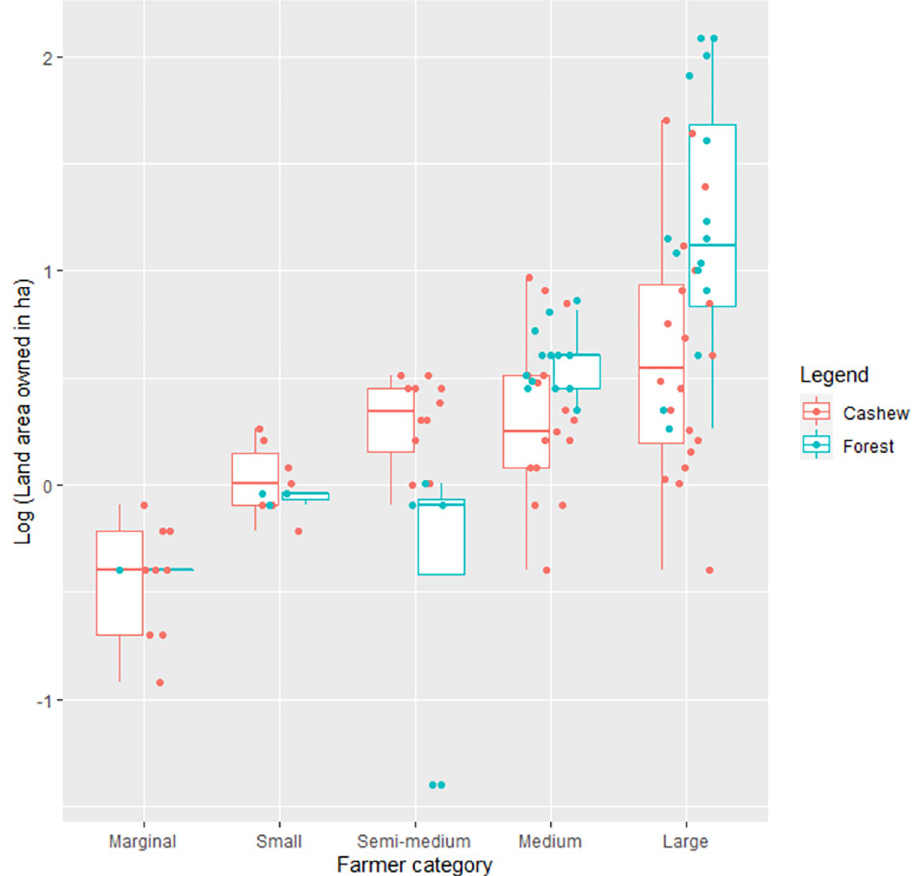
Fig 4. Boxplots of land area under cashew cultivation and forests owned by all farmers’ categories in the Sawantwadi-Dodamarg landscape, South Maharashtra, India.